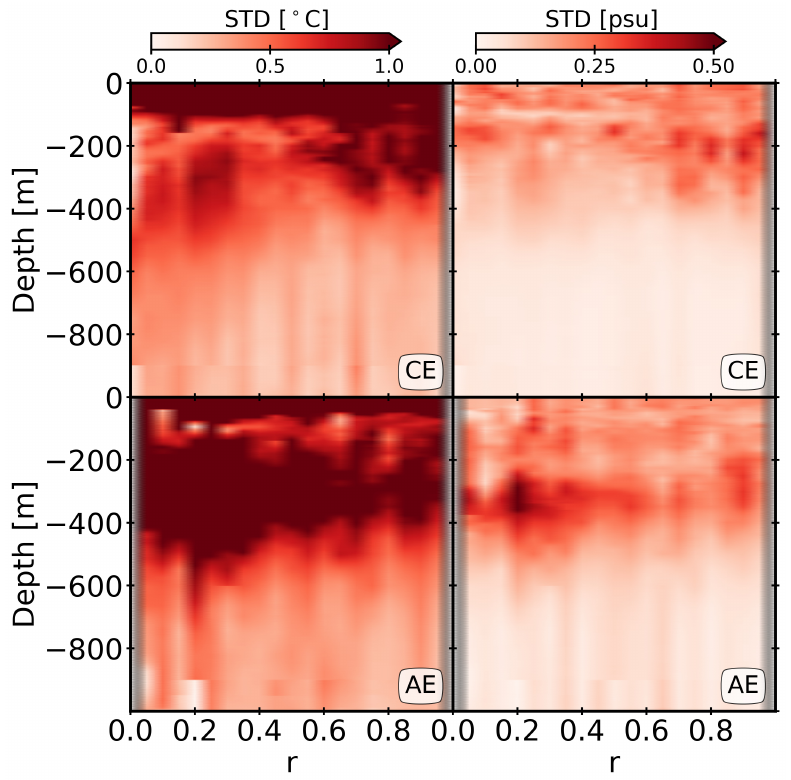
Figure A1. The standard deviation (STD) of the temperature and salinity anomalies for the AE and CE of the RAH